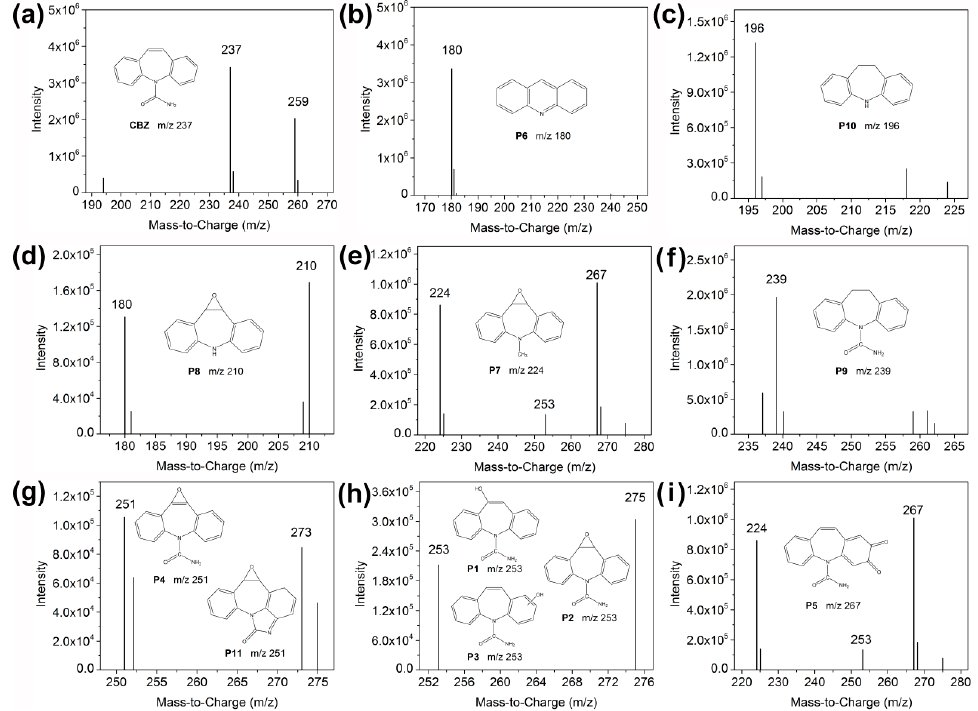
Figure 11. LC–MS spectra of ( a ) CBZ and the possible intermediates; ( b ) m / z 180; ( c ) m / z 196; ( d ) m / z 210; ( e ) m / z 224; ( f ) m / z 239; ( g ) m / z 251; ( h ) m / z 253; ( i ) m / z 267.